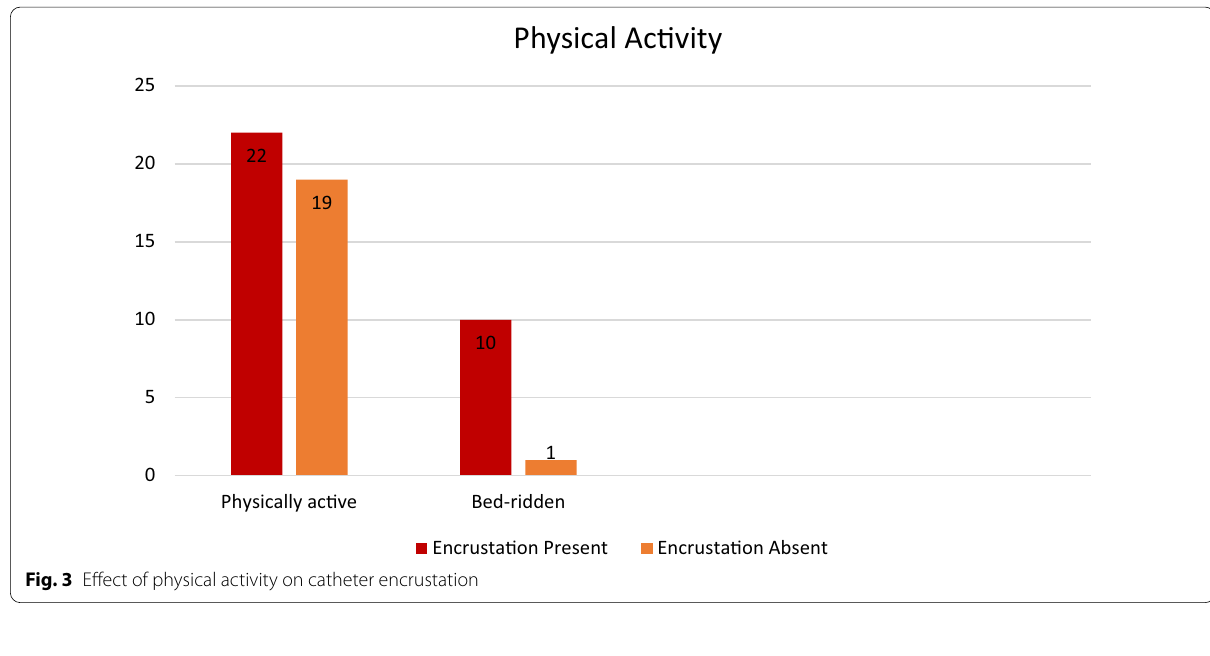
Fig. 3 Effect of physical activity on catheter encrustation